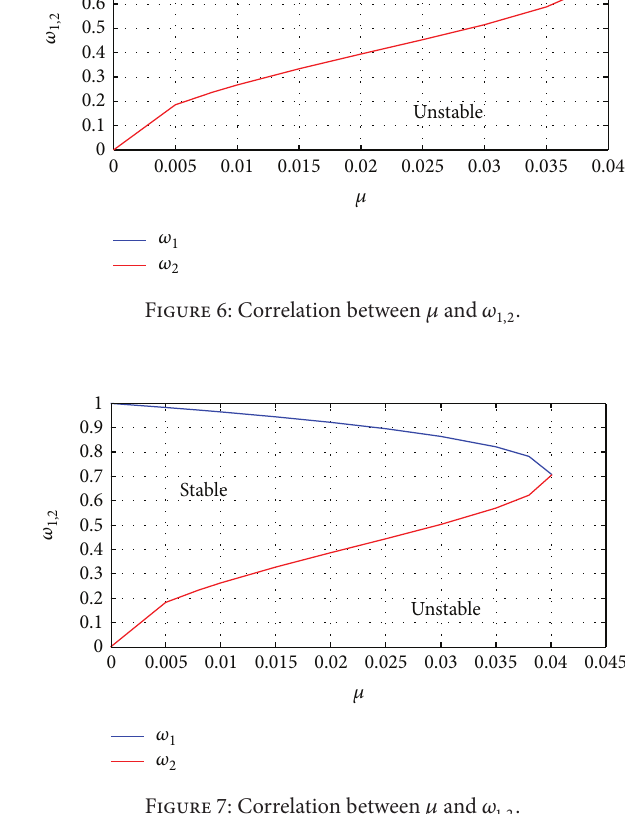
Figure 7: Correlation between 𝜇 and 𝜔 1,2